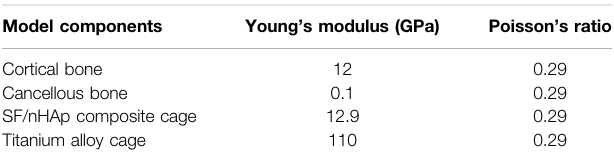
TABLE 1 | Mechanical properties of model components. Model components